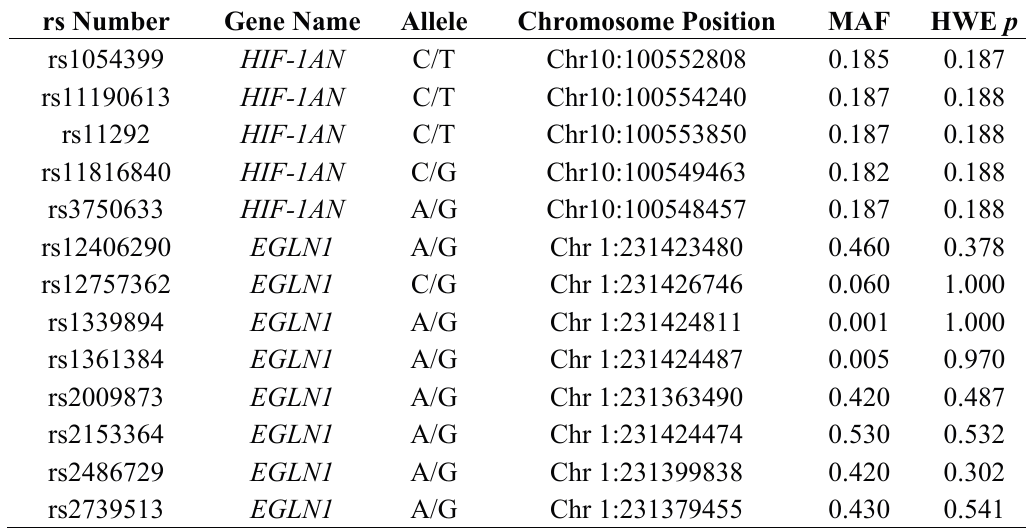
Table 2. Basic single nucleotide polymorphism (SNP) information.